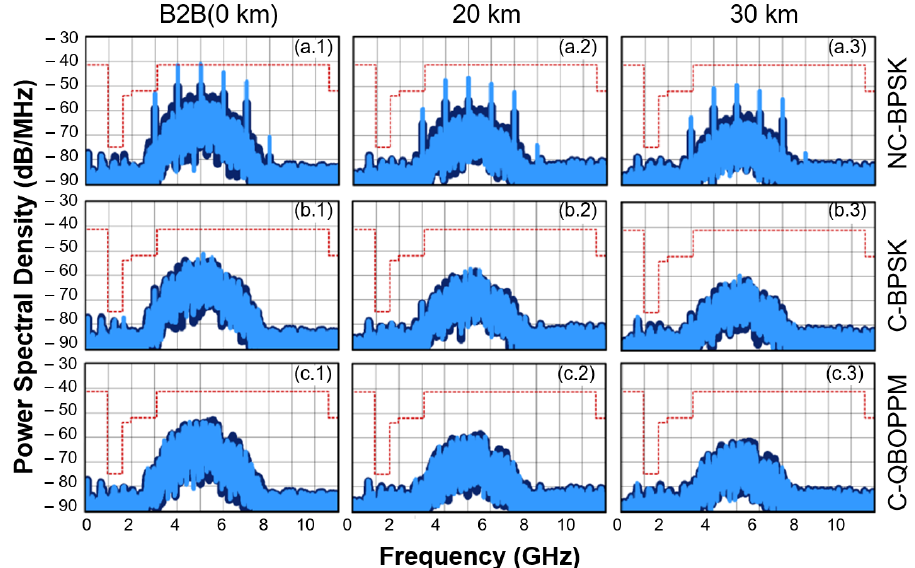
Figure 12. Measured PSDs of signals generated by: ( a ) the noncoded -BPSK IR-UWBoF-EIM/DD system (first row labelled as NC-BPSK—plots a.1 , a.2 and a.3 ); ( b ) the SLF convolutionally coded BPSK IR-UWBoF-EIM/DD system (second row labelled as C-BPSK—plots b.1 , b.2 and b.3 ); and ( c ) the SLF convolutionally coded Q-BOPPM IR-UWBoF-EIM/DD system (third row labelled as C-Q-BOPPM—plots c.1 , c.2 and c.3 ). The PSDs were obtained at Test Point C, pointed out in Figure 5, after 0 km (first column—plots a.1 , b.1 and c.1 ), 20 km (second column—plots a.2 , b.2 and c.2 ) and 30 km (third column—plots a.3 , b.3 and c.3 ) of SMF and wireless transmission.